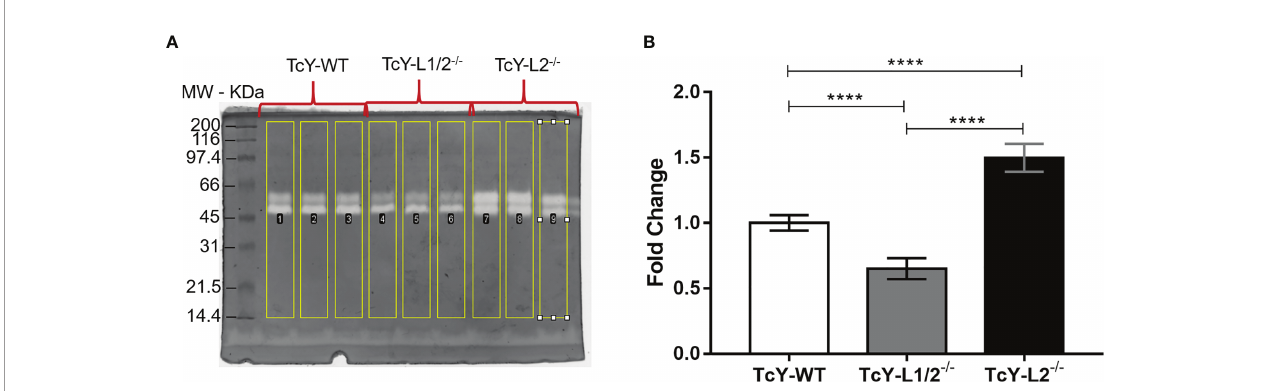
FIGURE 5 | Increased proteolytic activity of TcY-L2 − / − assessed by gelatin zymography assays. (A) Representative SDS-PAGE gel showing the negative bands from gelatinolytic activity. (B) Quanti fi cation obtained from gels using ImageJ software — TcY-WT values were used as a normalizer for all groups. Asterisks represent statistical difference between groups (****p < 0.0001, one-way ANOVA, Fisher ’